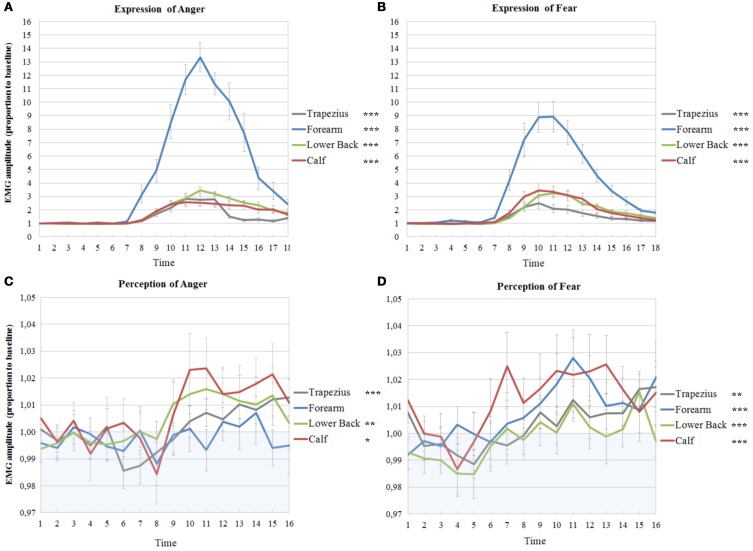
Muscle activations in experiment 1 and 2 on the right side of the body. EMG amplitudes and standard errors of the mean of muscles on the right during active imitation of anger (A) and fear (B) and during passive viewing of anger (C) and fear (D). The first six time points represent EMG activity during stimulus presentation. Activity below one (in blue area) indicates deactivation as compared to baseline. Significance levels of the fixed effect of time; ***p < 0.001, **p < 0.01, *p < 0.05.